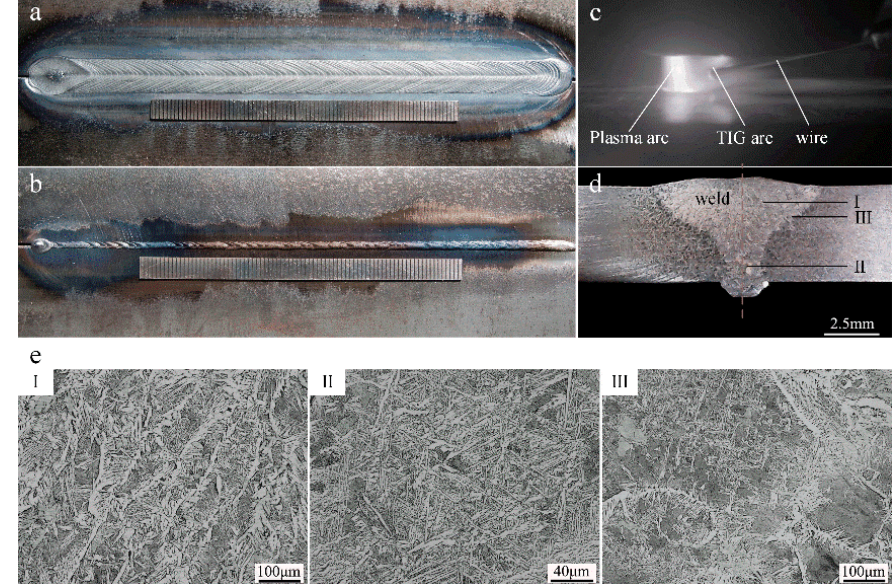
Figure 13. Appearance and microstructure of the weld. ( a ) The surface of the weld. ( b ) The back of the weld. ( c ) The coupled arc welding process with filler wire. ( d ) The cross-section of the weld. ( e ) The microstructure of the cross section.